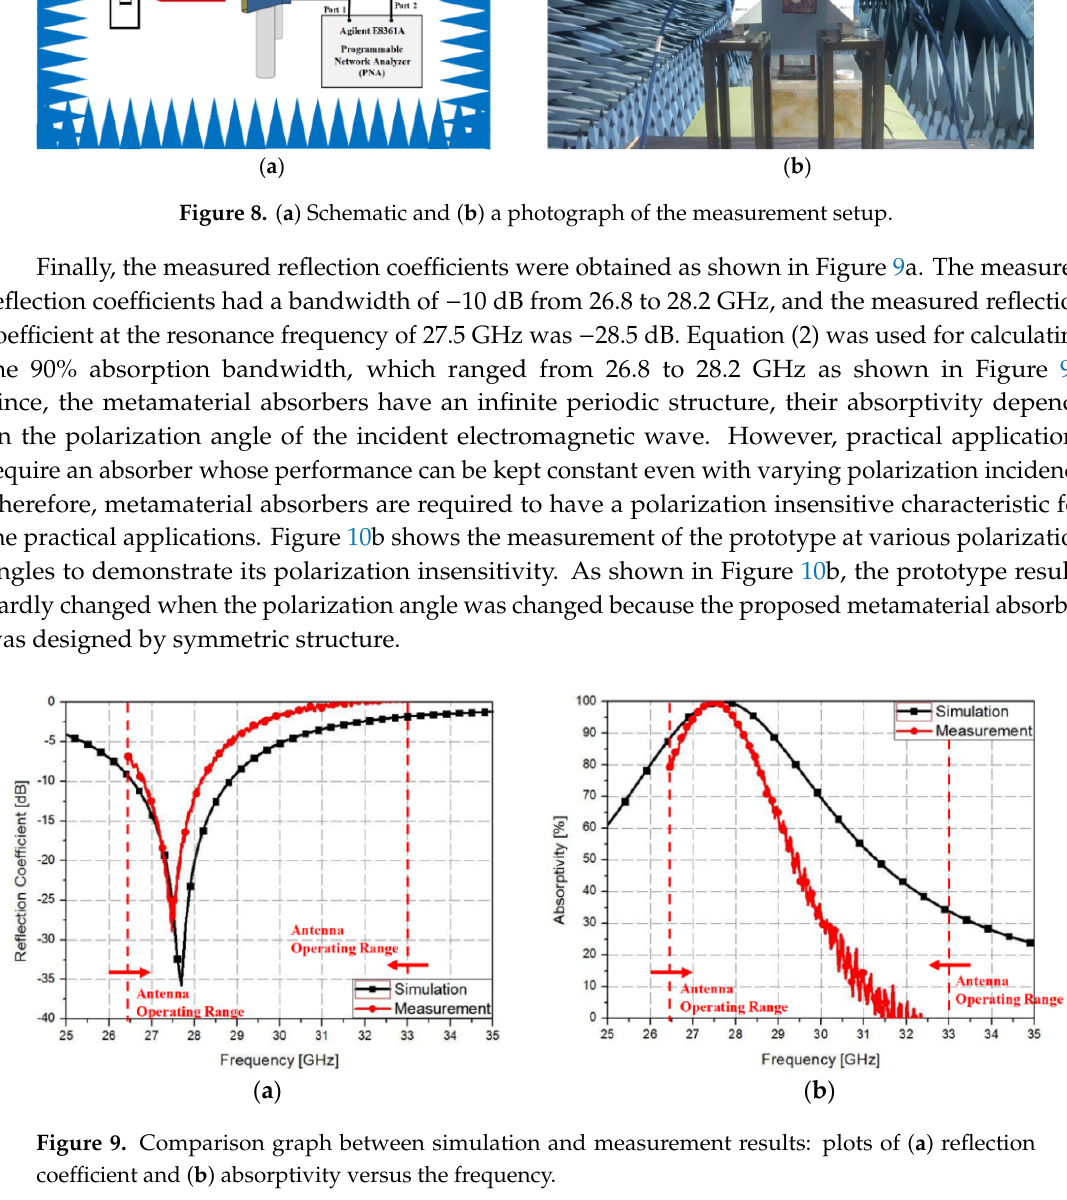
Figure 7. Fabricated prototype and magnified view of the printed surface.